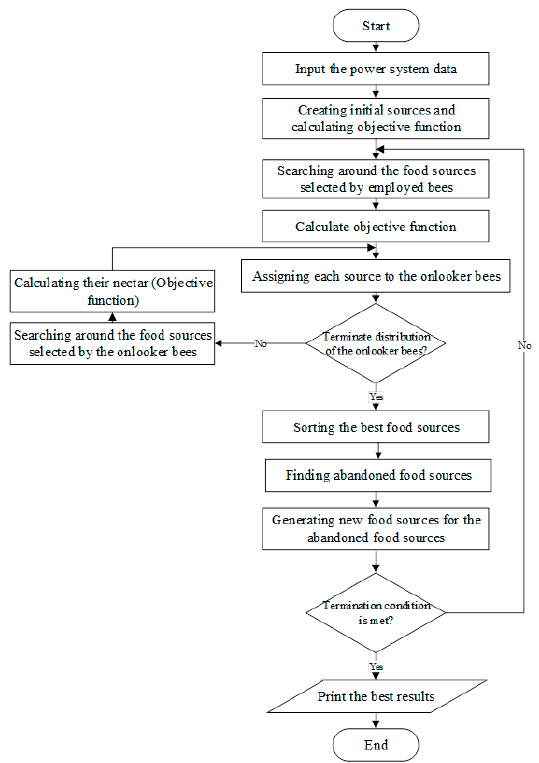
Figure 4. Flowchart of solving the problem.